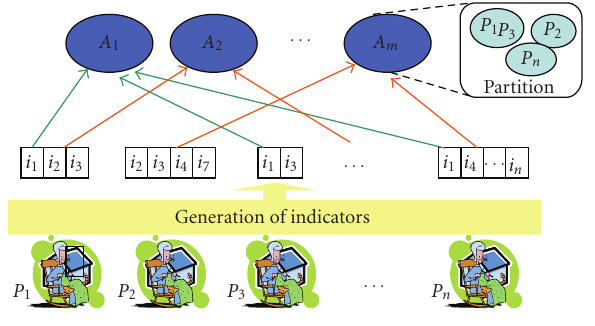
Figure 1: S(MA) 2 D